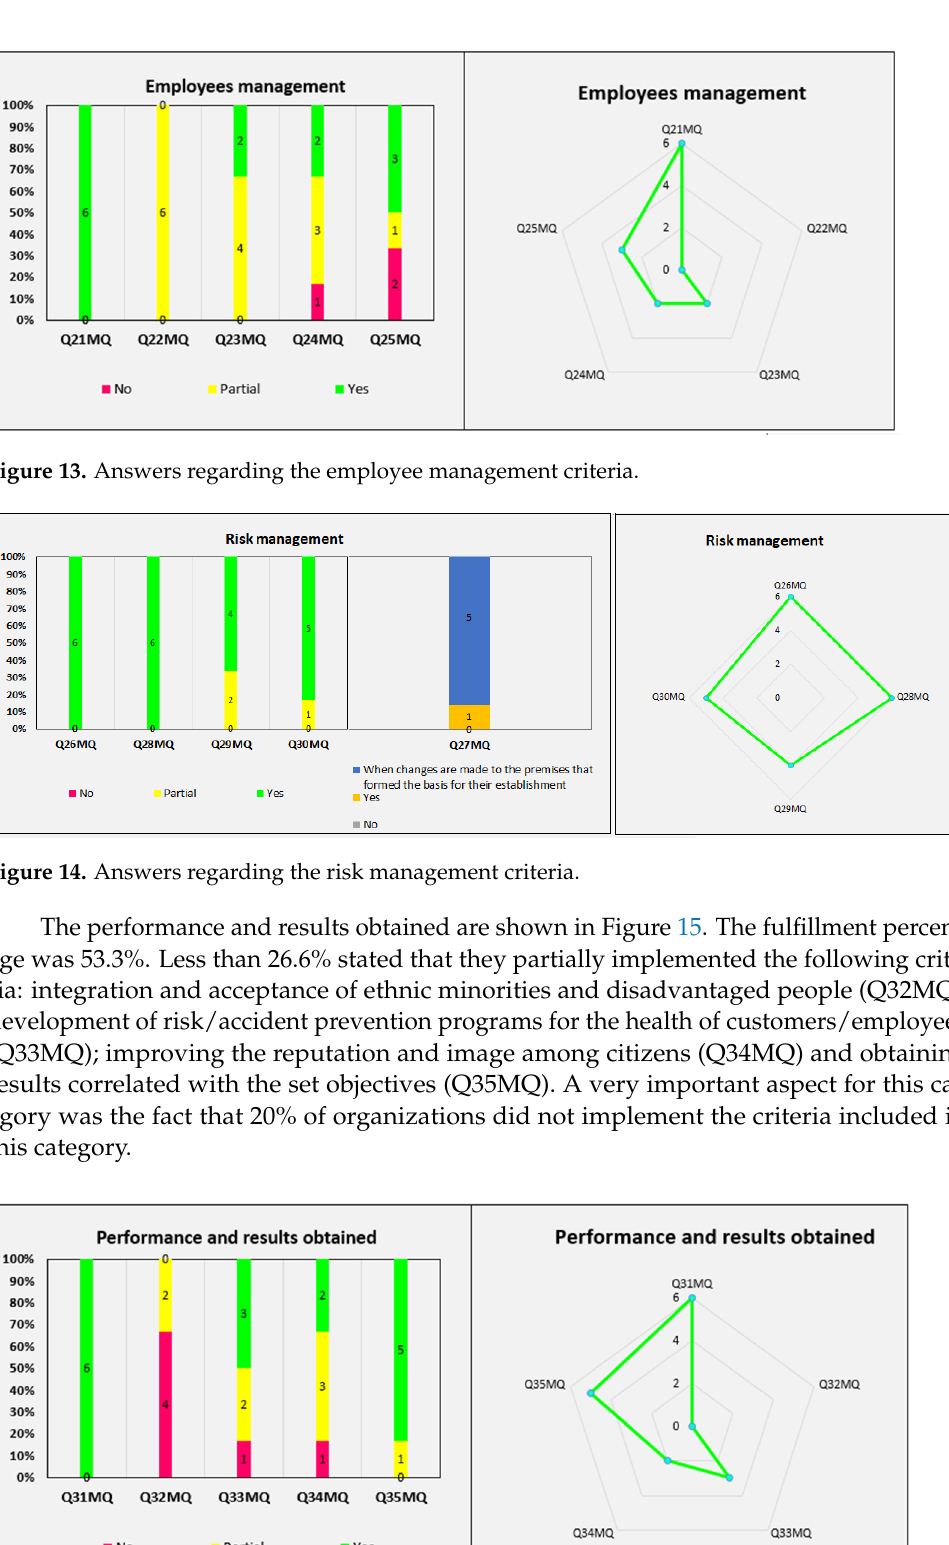
Figure 12. Answers regarding the customer management criteria.